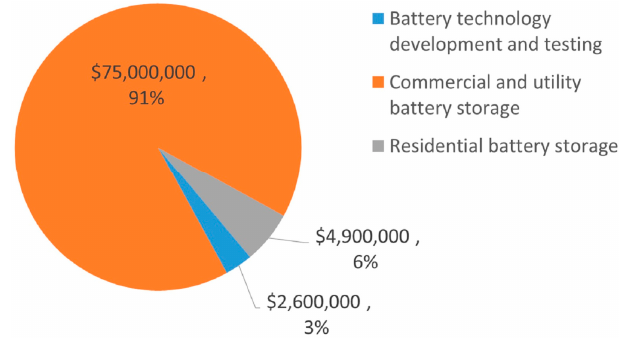
Figure 8. Australian Renewable Energy Agency (ARENA) battery storage funding (created from data obtained from [71]).